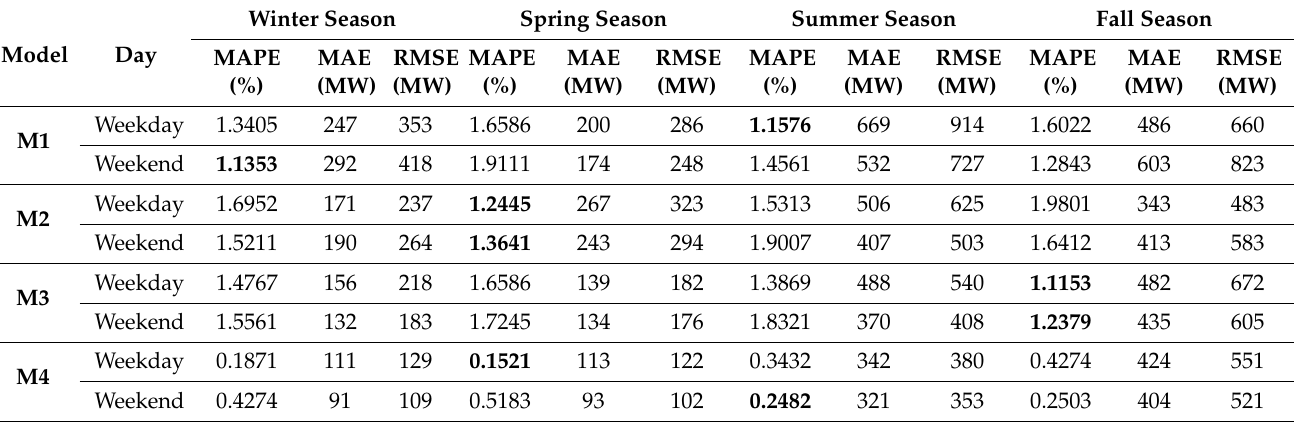
Table 3. Weekday and weekend seasonal forecasted results.